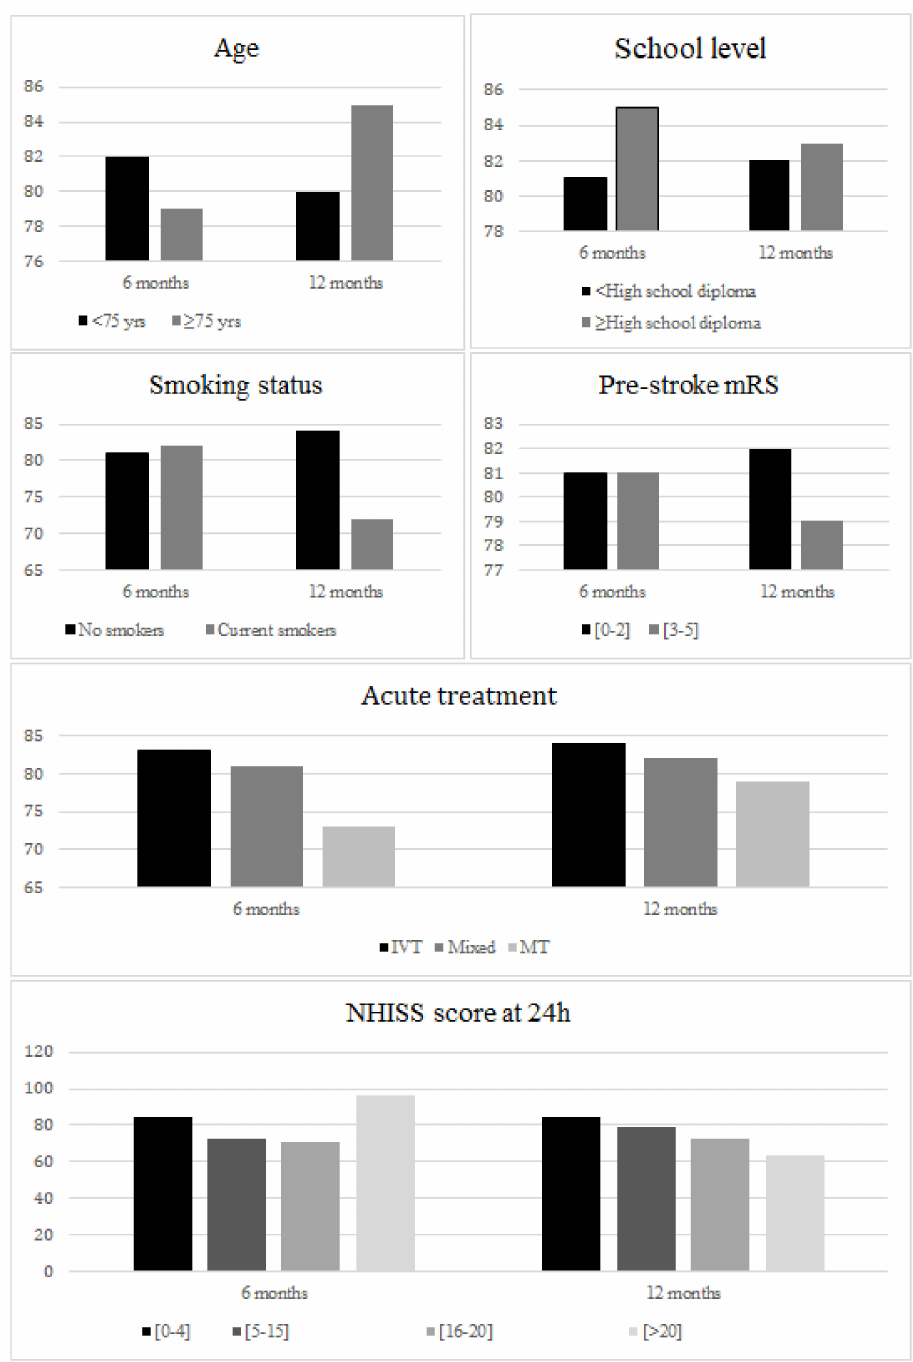
Figure 4. Mean mood score at 6 months and 12 months according to patients’